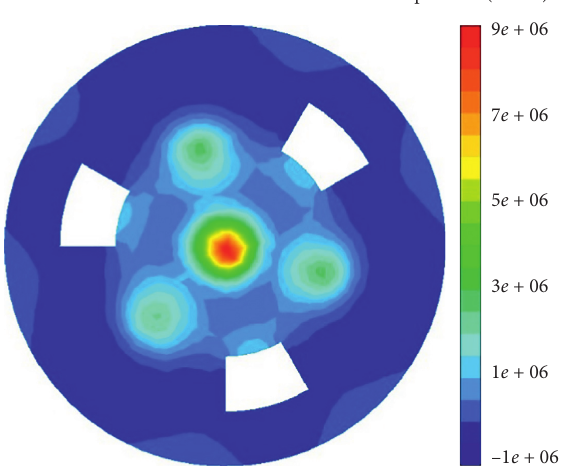
Figure 10: Bottom hole static pressure distribution cloud image of the polymer additive jet.